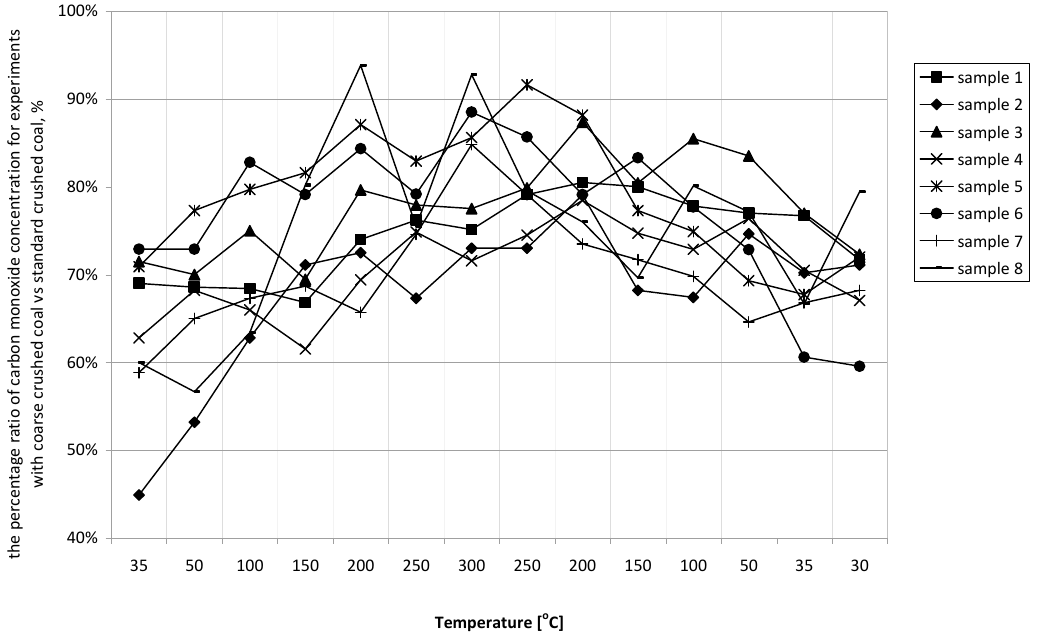
Figure 8. The course of changes in the ratio of released carbon monoxide (for both coarse and standard crushing) in the stages of heating and cooling of coal samples.